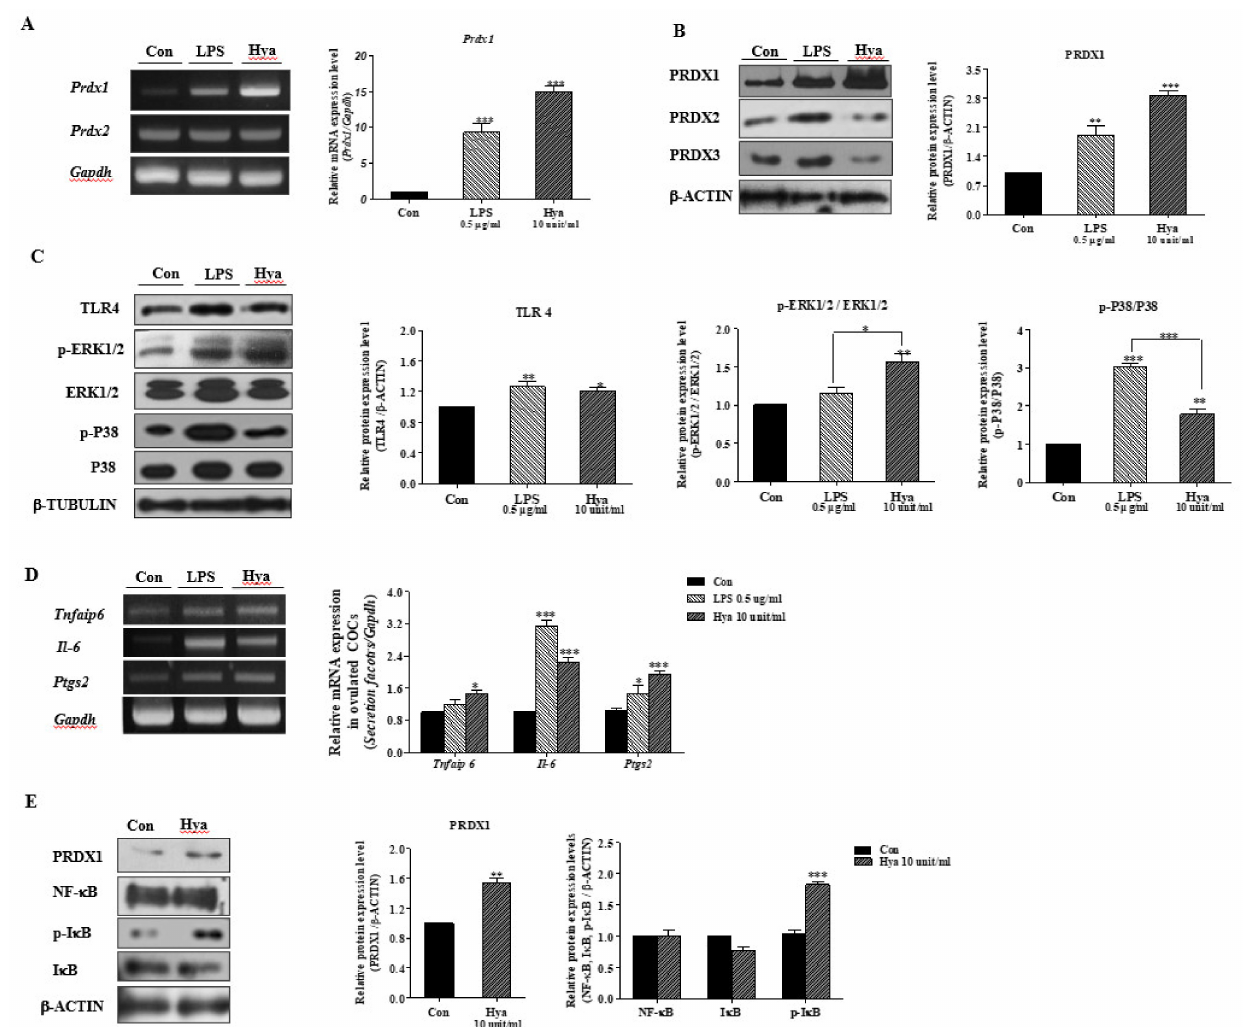
Figure 2. Changes in PRDX1 protein levels and TLR4-derived ERK1/2 signaling in ovulated cumulus–oocyte complexes (COCs) by LPS or Hya treatment. ( A ) The mRNA expression levels of antioxidant enzymes ( Prdx1 and Prdx2 ) and CC- secreted factors or ( D ) immune-modulatory factors ( Tnfaip6, Il-6, and Ptgs2 ) in ovulated COCs after LPS and Hya treatment were measured by RT-PCR analysis. The mRNA levels of these genes were normalized to the Gapdh mRNA expression level as a control. ( B ) The protein levels of PRDXs (PRDX1, -2, and -3) and ( C,E ) TLR4-targeted signal genes (TLR4, p-ERK1/2, and ERK1/2, p-P38, P38 MAP kinase, and NF- κ B signaling) in ovulated COCs after culturing with LPS or Hya were measured by Western blot analysis. The relative fold changes of these proteins were obtained by normalization to the signals for β -ACTIN and β -TUBULIN. p-ERK1/2 and p-P38 were normalized to total ERK1/2 and P38 protein. The histogram represents the values of the densitometry analysis that were obtained using Image J software. Data in the bar graph represent the means ± SEM of three independent experiments (25–30 COCs per group). *, p < 0.05; **, p < 0.01; ***, p < 0.001 for analysis of these data via t -tests and Dunnett’s multiple comparison test compared with the control